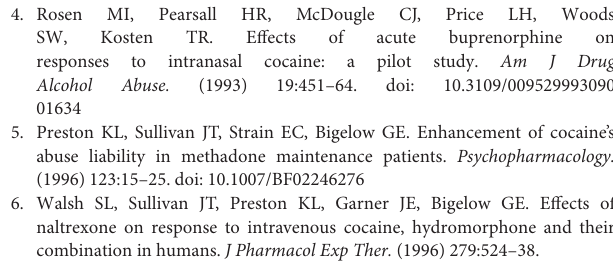
FIGURE 3 | dose of d -amphetamine in mg/kg. Points above “0” represent the effects of vehicle (saline) and various doses of opioids tested alone. Vertical lines represent the SEM; where not indicated, the SEM fell within the data point. Single asterisk indicates significant effect of opioid alone. Asterisk with horizontal line indicates significant effect of amphetamine dose. Asterisk with vertical line indicates significant effect of opioid